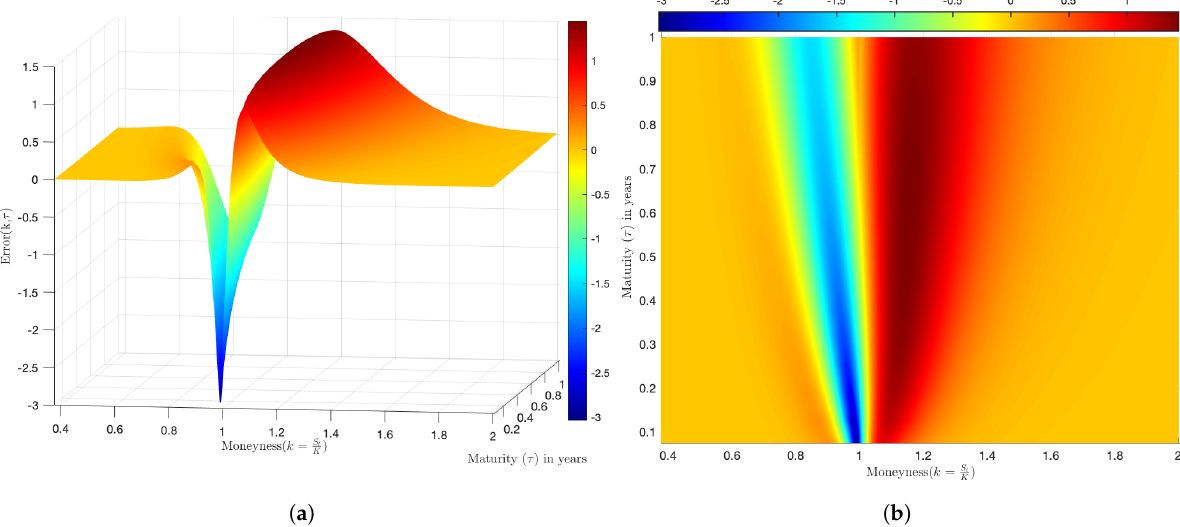
Figure 10. Combined effects of Time to Maturity ( τ ) and option Moneyness ( k = S t and ( b ) error (k, τ ) (top